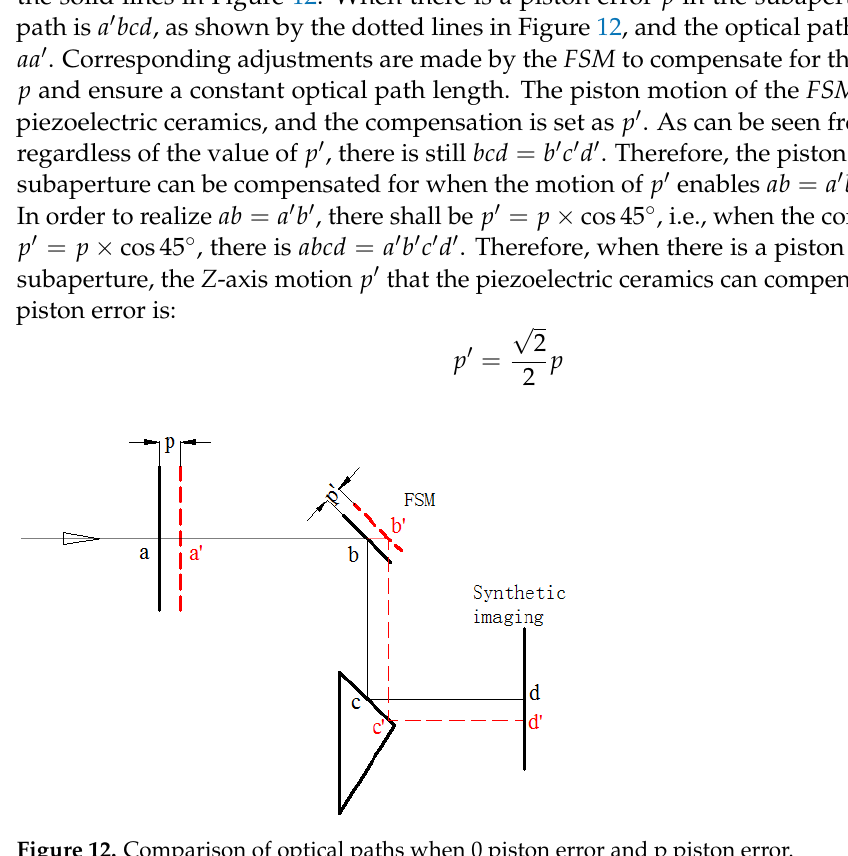
8 of 13 Figure 11. Vibration analysis of the FSM structure: ( a ) 7th order vibration mode, ( b ) 1st–10th order mode natural frequency, ( c ) strain analysis of harmonic response in 7000 Hz, and ( d ) frequency–displacement curve of harmonic response. 3.2. Analysis of Beam Adjustment Capability According to the design scheme of the beam steering and adjustment structure, the sub-light path piston error is controlled at 12 μm and the tilt error is controlled at 1200 μrad through the “Three Screws for Pull and Three Screws for Push” structure of the FSM rough adjustment. The piston error and tilt error are then precisely adjusted by the